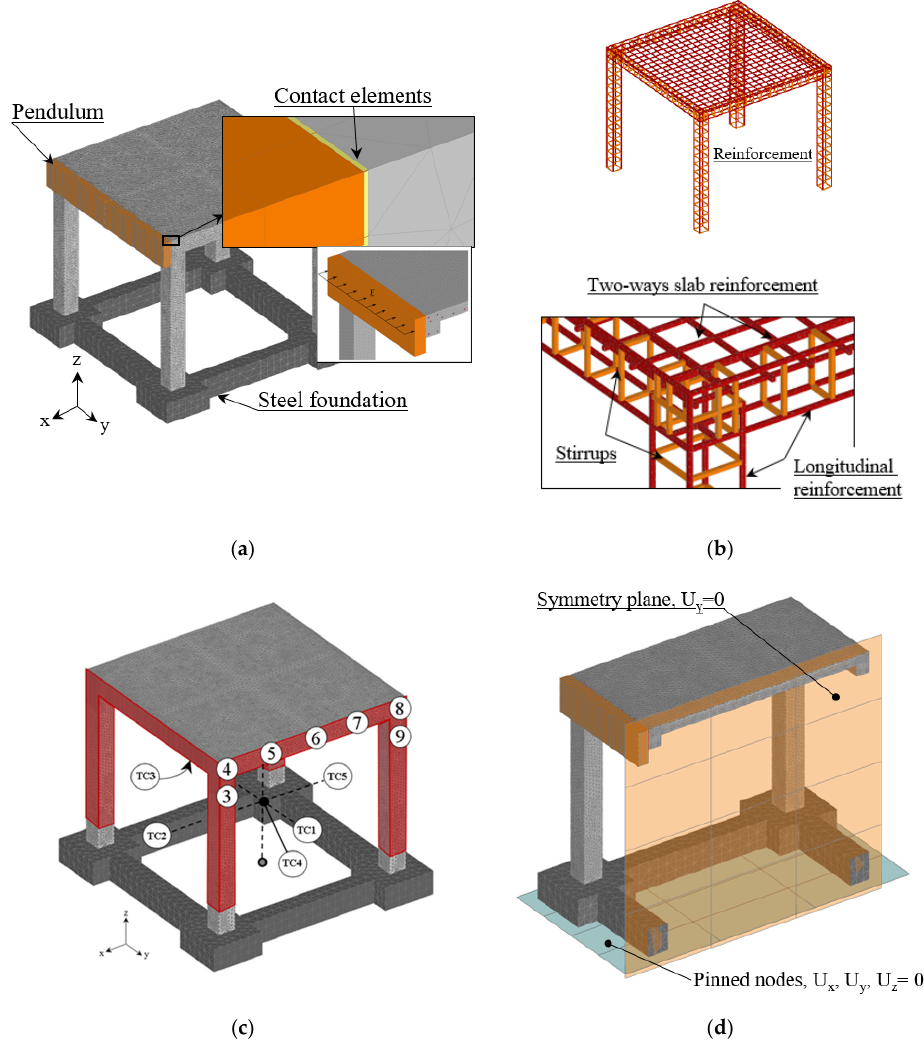
Figure 5. 3D finite element discretization of the frame: ( a ) RC frame, pendulum and contact elements, ( b ) main reinforcement and stirrups, ( c ) heated surfaces of the frame in red including bottom surface of the slab and ( d ) symmetry plane and boundary conditions. Table 1. Summary of basic material properties for concrete and